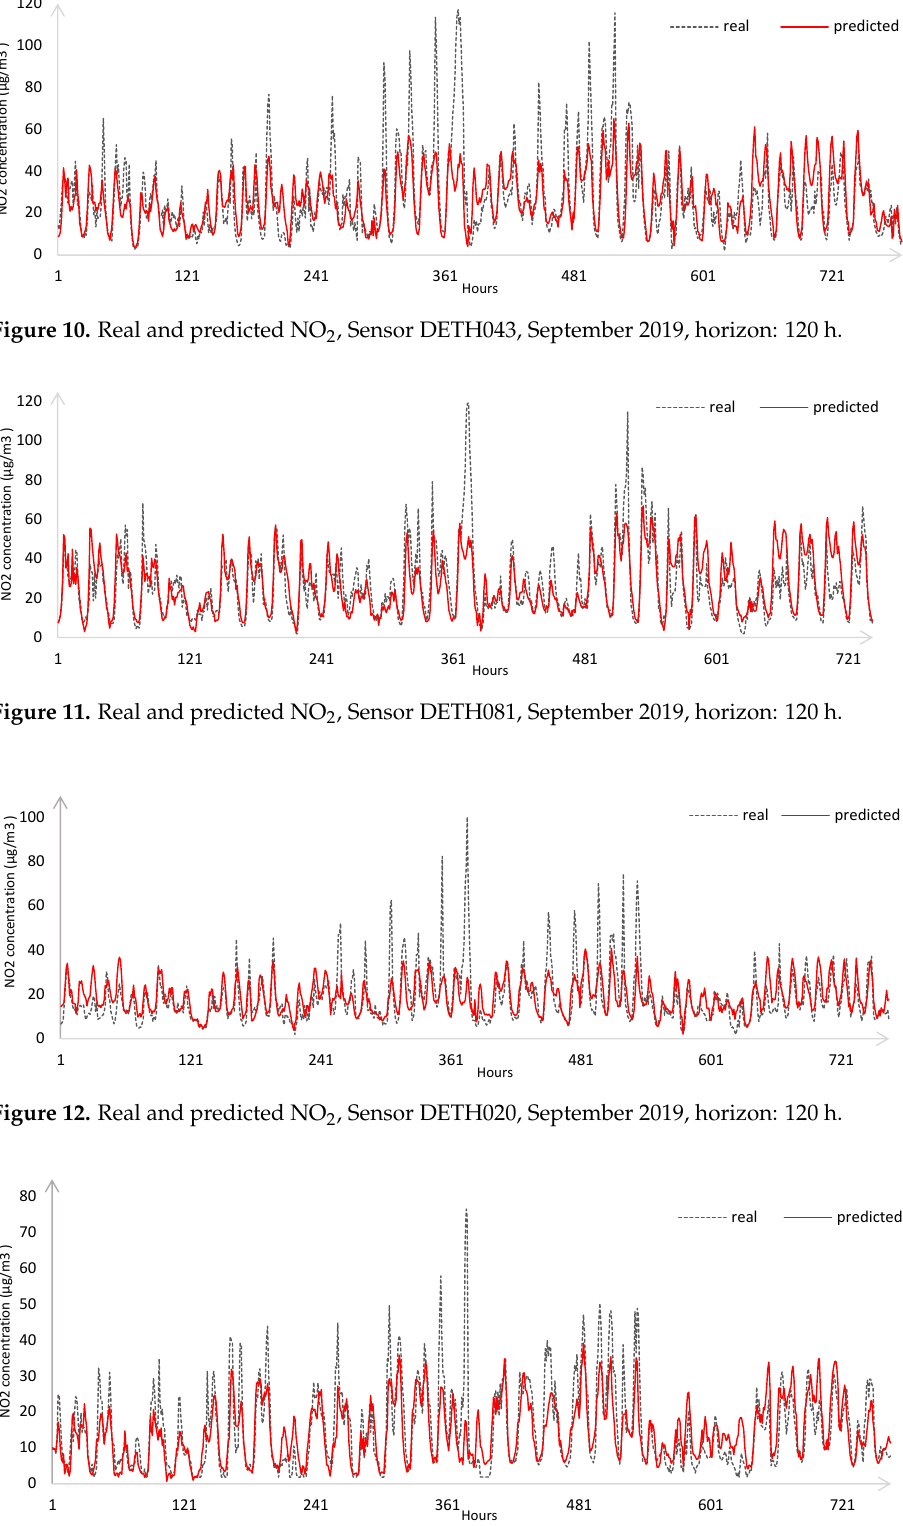
Figure 13. Real and predicted NO 2 , Sensor DETH117, September 2019, horizon: 120 h. Despite the four studied sensors registering the high outliers, sensors DETH043 and DETH081 reached the highest values, with almost 120 µ g m 3 , and sensor DETH117 (the one located in the rural area) registering the lowest